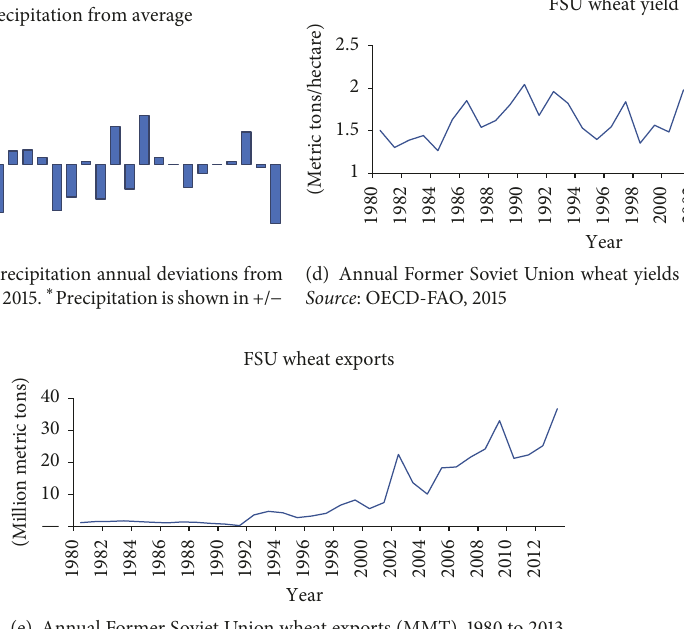
Figure 11: Former Soviet